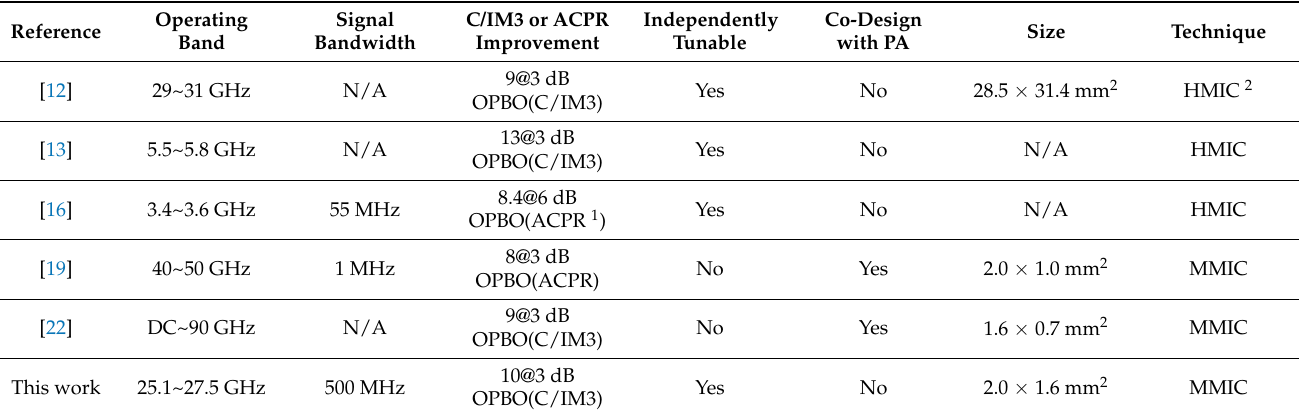
Table 2. Comparison with similar APD